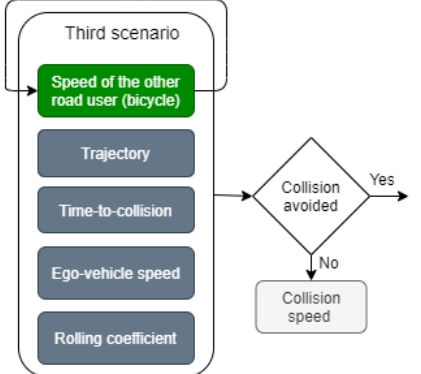
Figure 14. Parameters used in the sensitivity analysis in the third